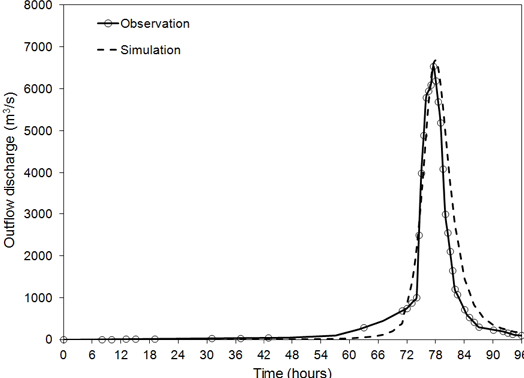
Fig. 9. Outflow hydrographs from the BREACH model and the ob- servational data.